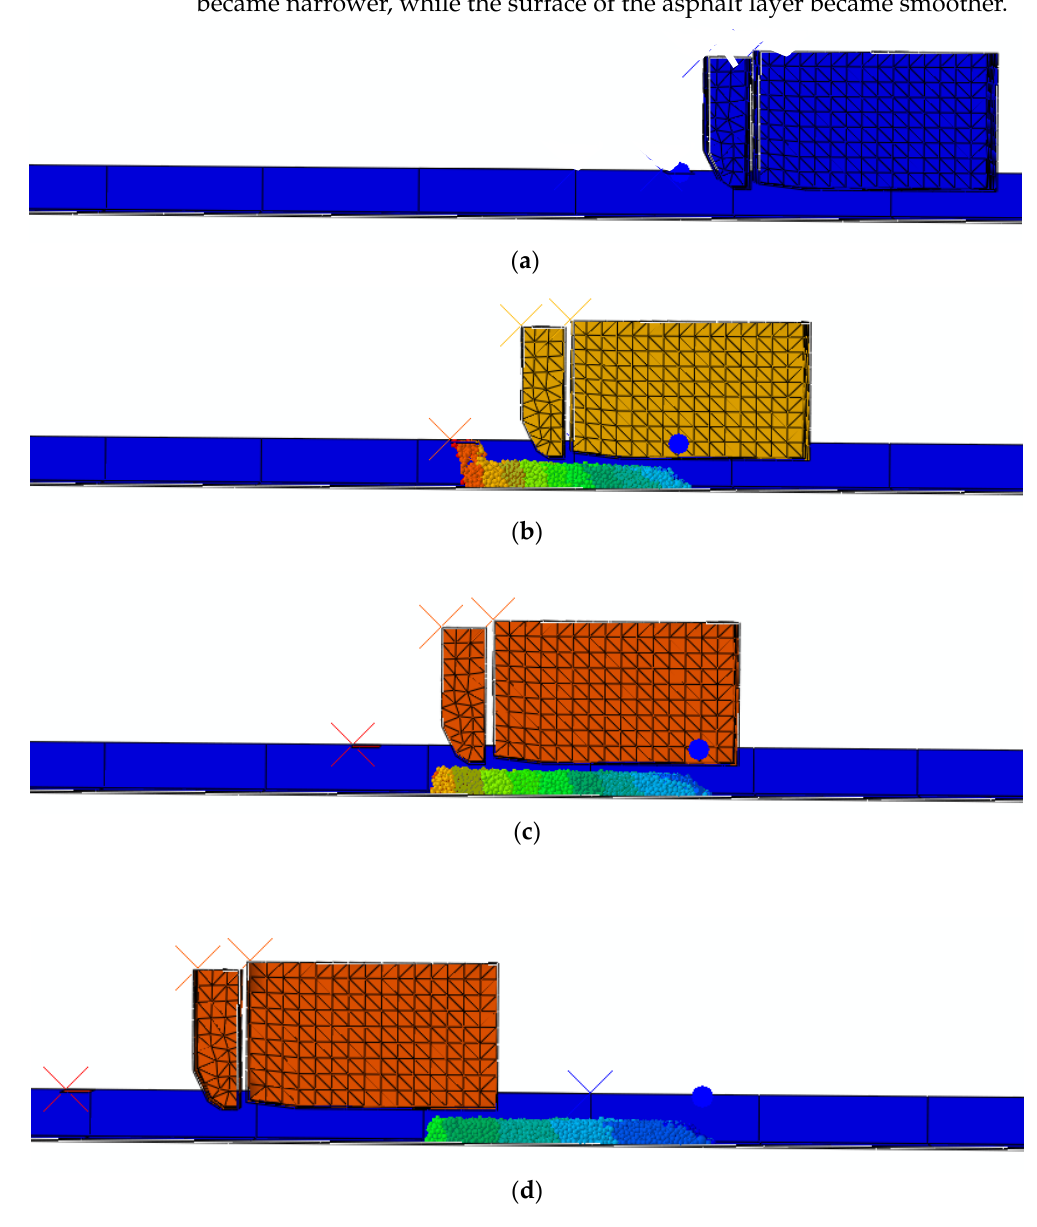
Figure 5. Three steps of this model: ( a ) The beginning of step 1 (t = 0); ( b ) The end of step 1, the beginning of step 2 (t = 2 s); ( c ) The end of step 2, the beginning of step 3 (t = 3 s); ( d ) The end of step 3 (t = 6 s).